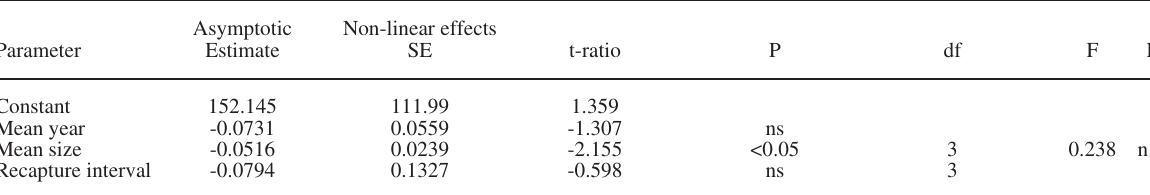
Table 1. – summary of parameter estimates of gaM (identity link, quasi-likelihood error term, cubic smoothing splines) fitted to Mediter- ranean loggerhead turtle growth rates. null deviance: 100.72 null df: 37, residual deviance: 64.351, residual df: 24.995, r 2 =0.36.